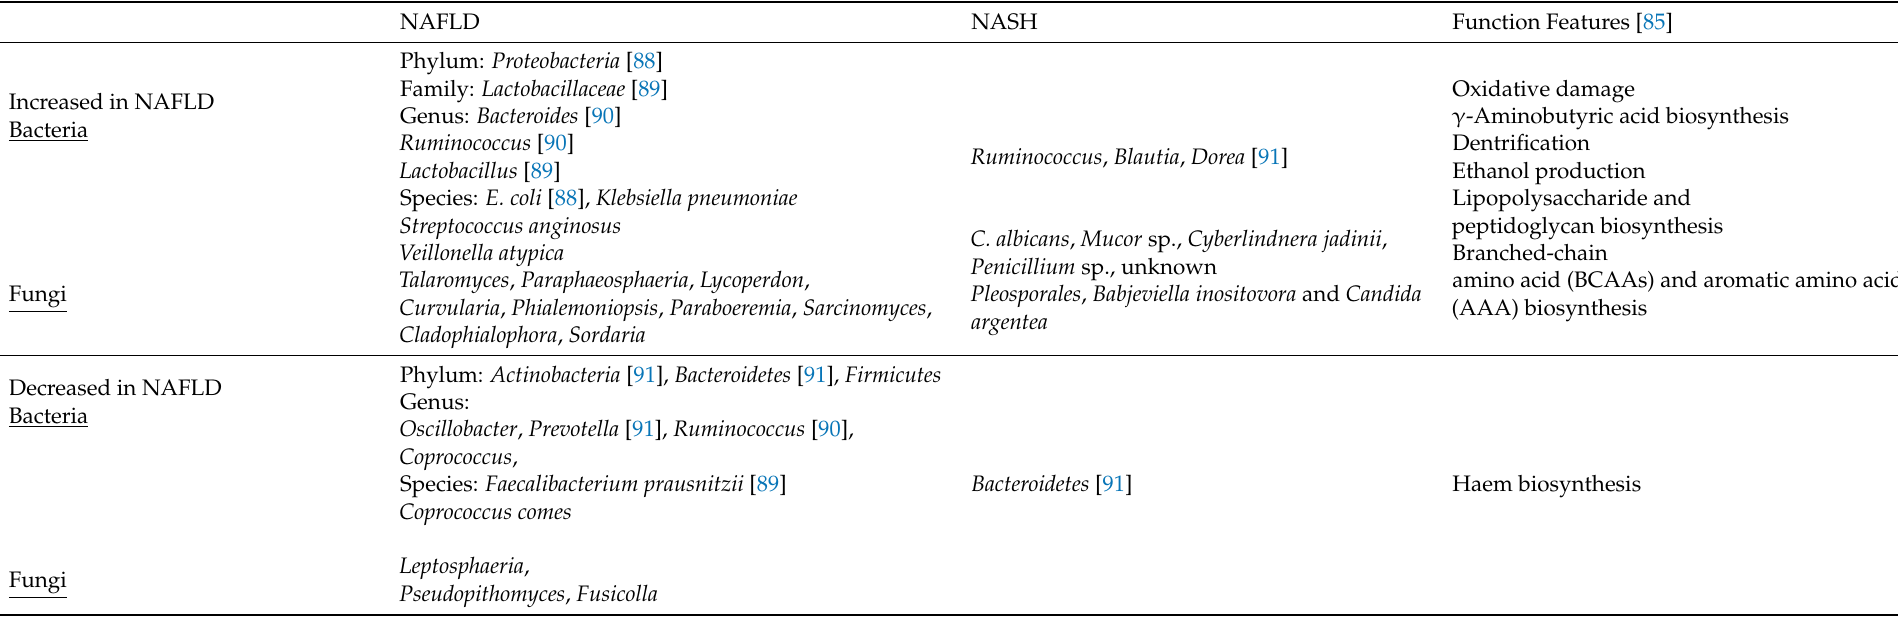
Table 2. Gut microbiome and mycobiome changes in NAFLD and